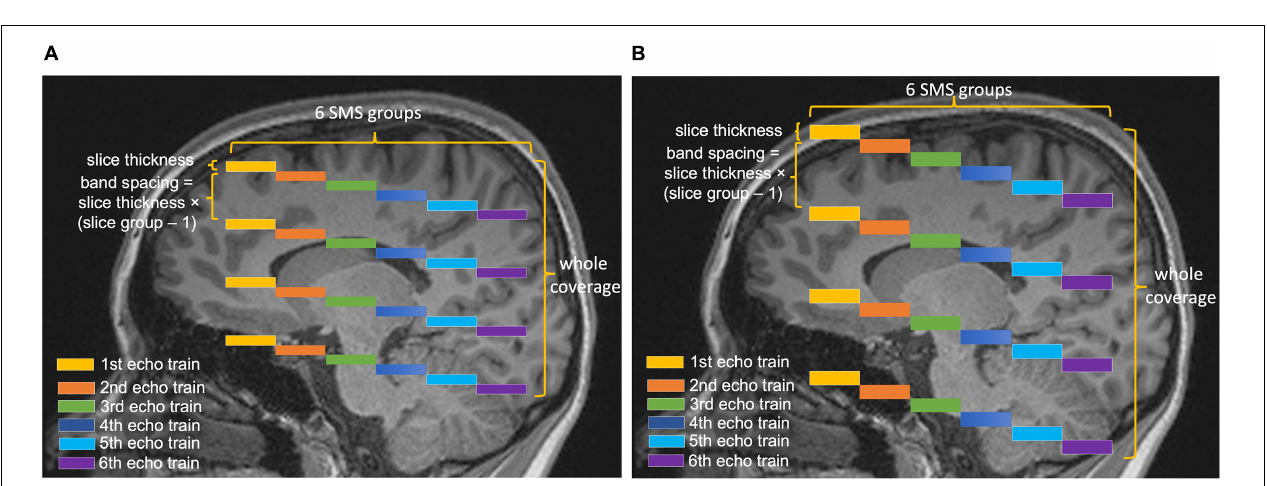
FIGURE 1 | SLIDER acquisition scheme. (A) SMS-EPI pCASL acquisition sequence for each set of low-resolution images, with constrained slice dependent background suppression. (B) Acquisition scheme for SLIDER2, SLIDER3, and SLIDER4; different numbers of scans with slice shift are needed, 2 for SLIDER2, 3 for SLIDER3, and 4 for SLIDER4. Then, high-resolution images can be reconstructed.